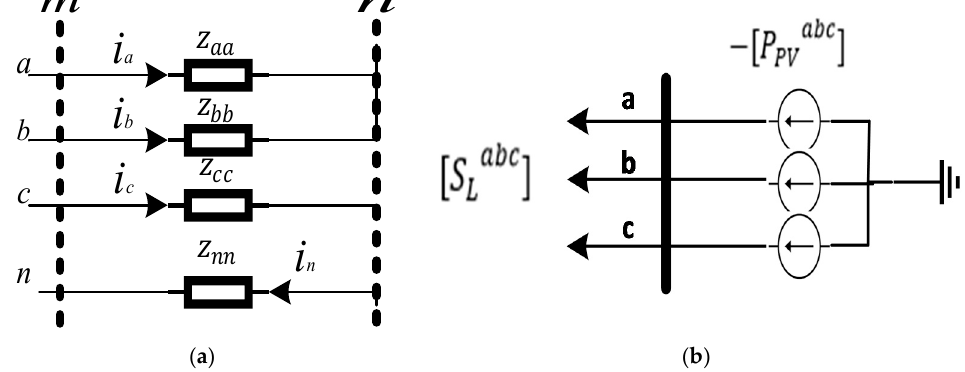
Figure 1. ( a ) Typical representation of a 3-phase 4-wire LV feeder segment; ( b ) Constant negative load PV model.